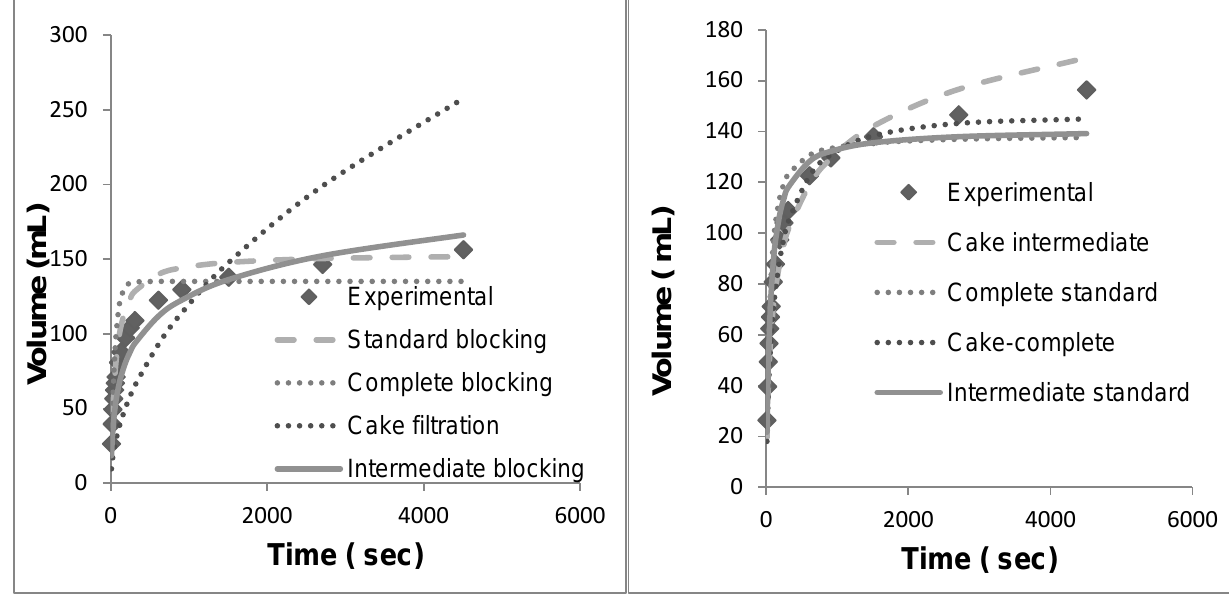
Figure 5. Volume vs. time data for individual models fit against the individual and combined models. ( A ) Individual models for PDK5. ( B ) Combined models for PDK5. ( C ) Individual models for PDH4. ( D ) Combined models for PDH4. ( E ) Individual models for PDE2. ( F ) Combined models for